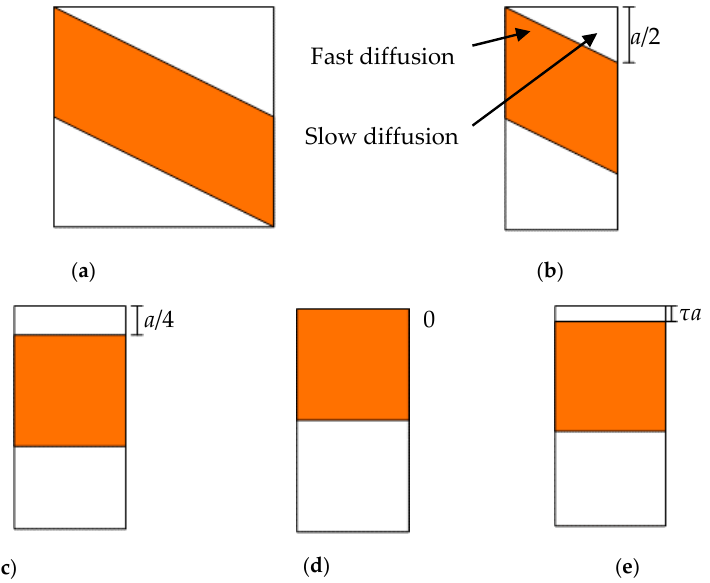
Figure 3. Moisture diffusion and equivalence structure analysis of part 4. ( a ) Part 4; ( b ) 1/2 Part 4; ( c ) Minimum equivalence; ( d ) Maximum equivalence; ( e ) Approximate equivalence.